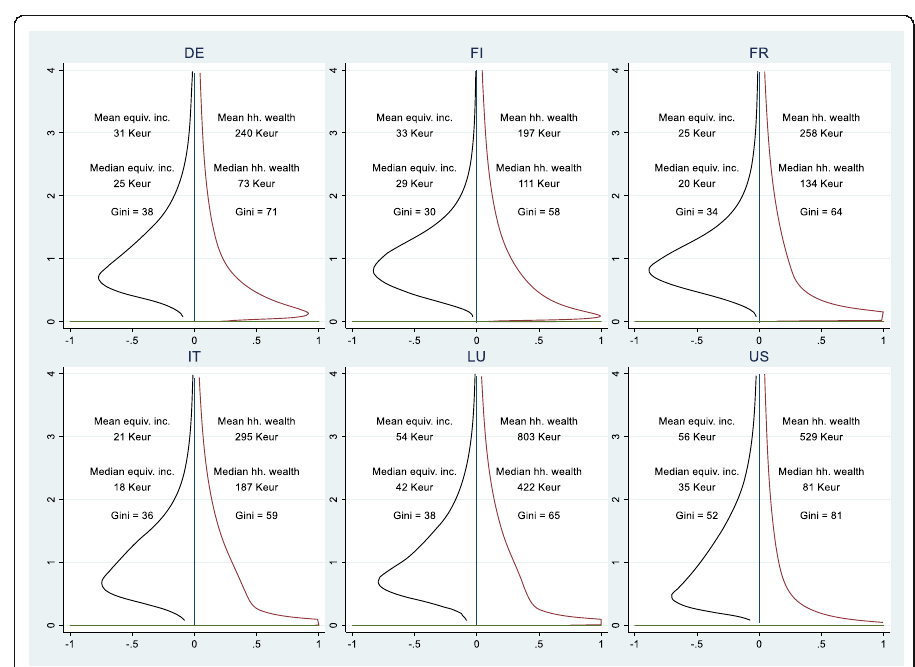
Fig. 4 Strobiloids (vertical density curves) of income (left) and wealth (right) in six countries. Note: Country codes refer respectively to DE Germany, FI Finland, FR France, IT Italy, LU Luxembourg, US the United States. The vertical axis represents the medianized levels of equivalized income (left) and household wealth (right). The horizontal axis represents density (surfaces are standardized to 1). The strobiloid is larger when a stronger density of the population is measured at this level of resource. At Y = 4, income/wealth is 4 times the median. In countries where a large share of the population has no wealth, the lower part of the strobiloid is truncated. Sources: Incomes from Luxembourg income study (LIS, https://www.lisdatacenter.org/) circa 2012, and wealth from EU-HFCS 2012 for European countries and SCF 2013 for the US. Authors ’ calculations and